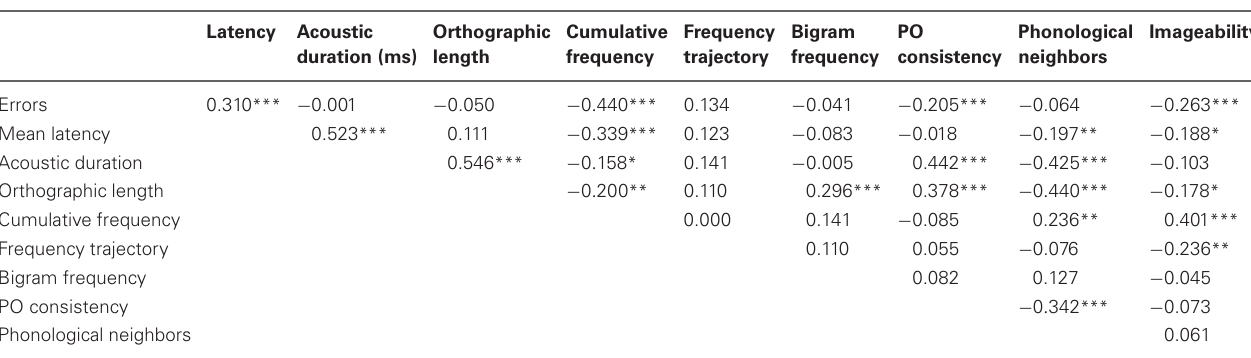
Table 3 | Correlations between the